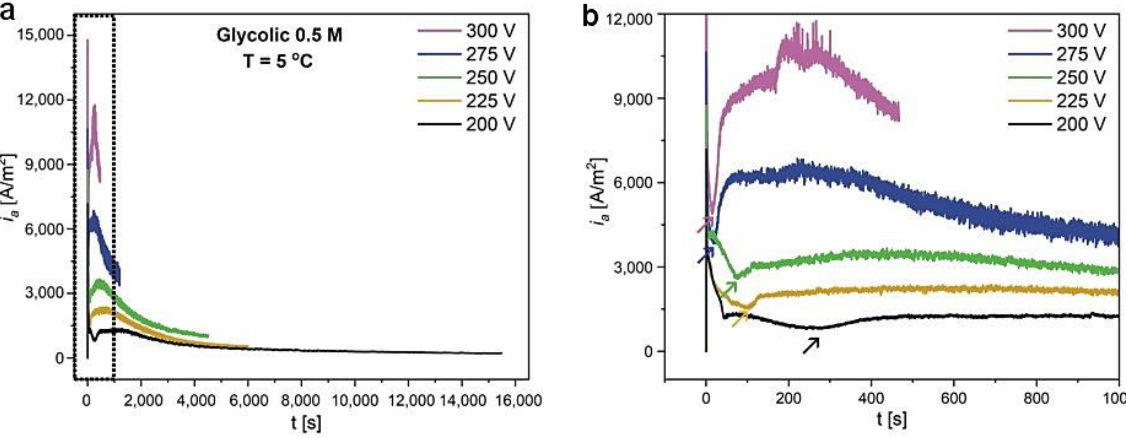
Figure 1. Current density ( i a ) versus time ( t ) transients for the samples anodized in 0.5 M glycolic acid water solution, at T = 5 °C, under different voltage ( a ); a larger magnification of the i a ( t ) curve (delineated by black, dotted rectangle) ( b ).